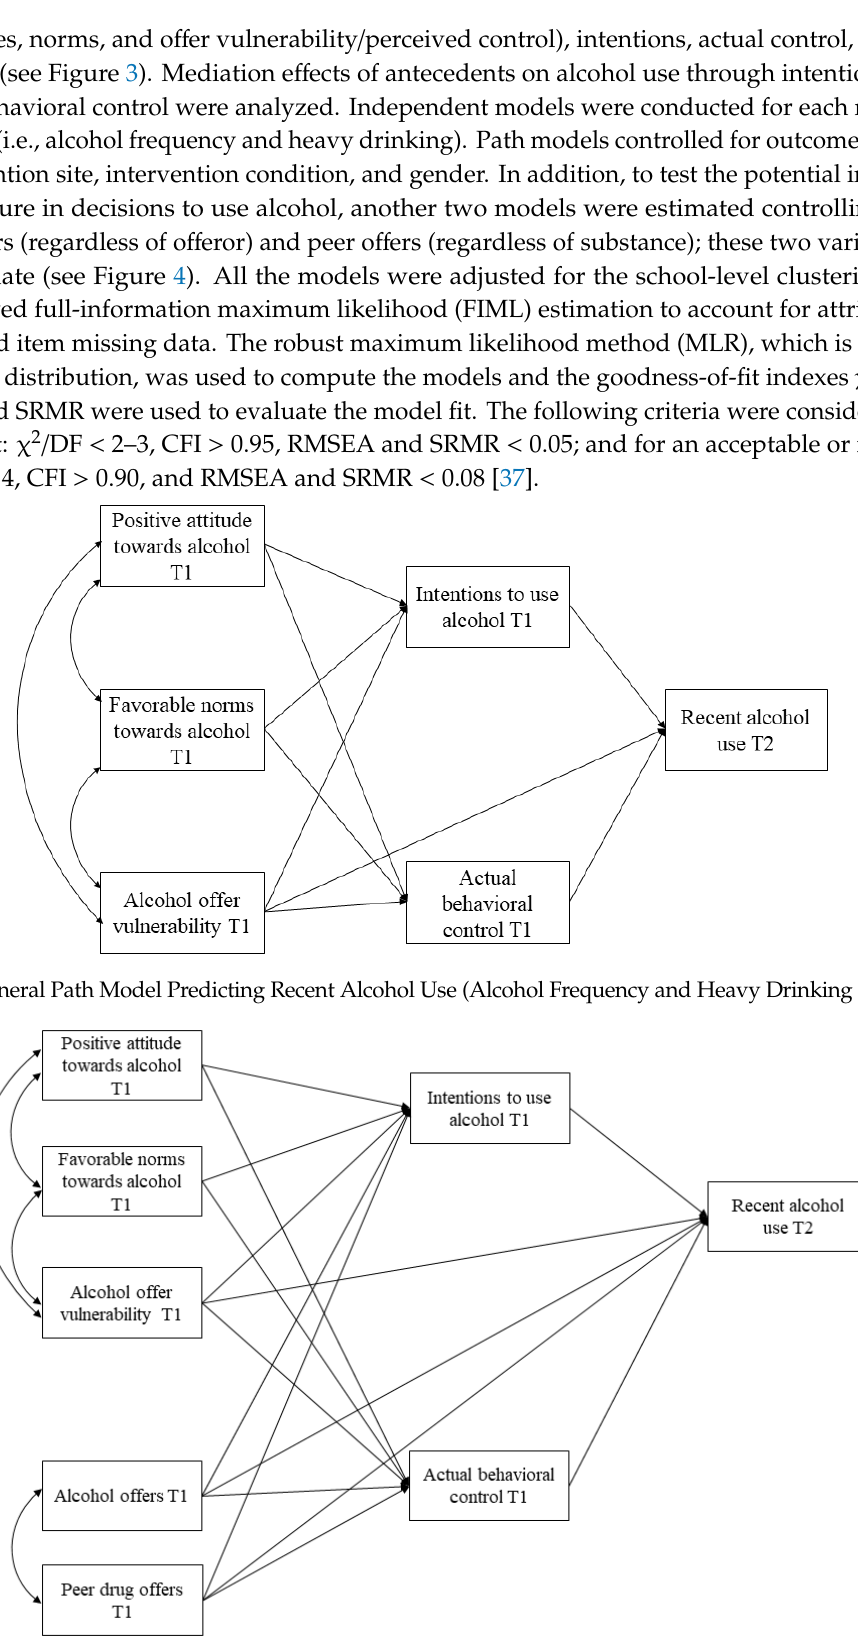
Figure 4. Path Model Predicting Recent Alcohol Use (Alcohol Frequency and Heavy Drinking Separately) Controlling for Negative Social Influence.